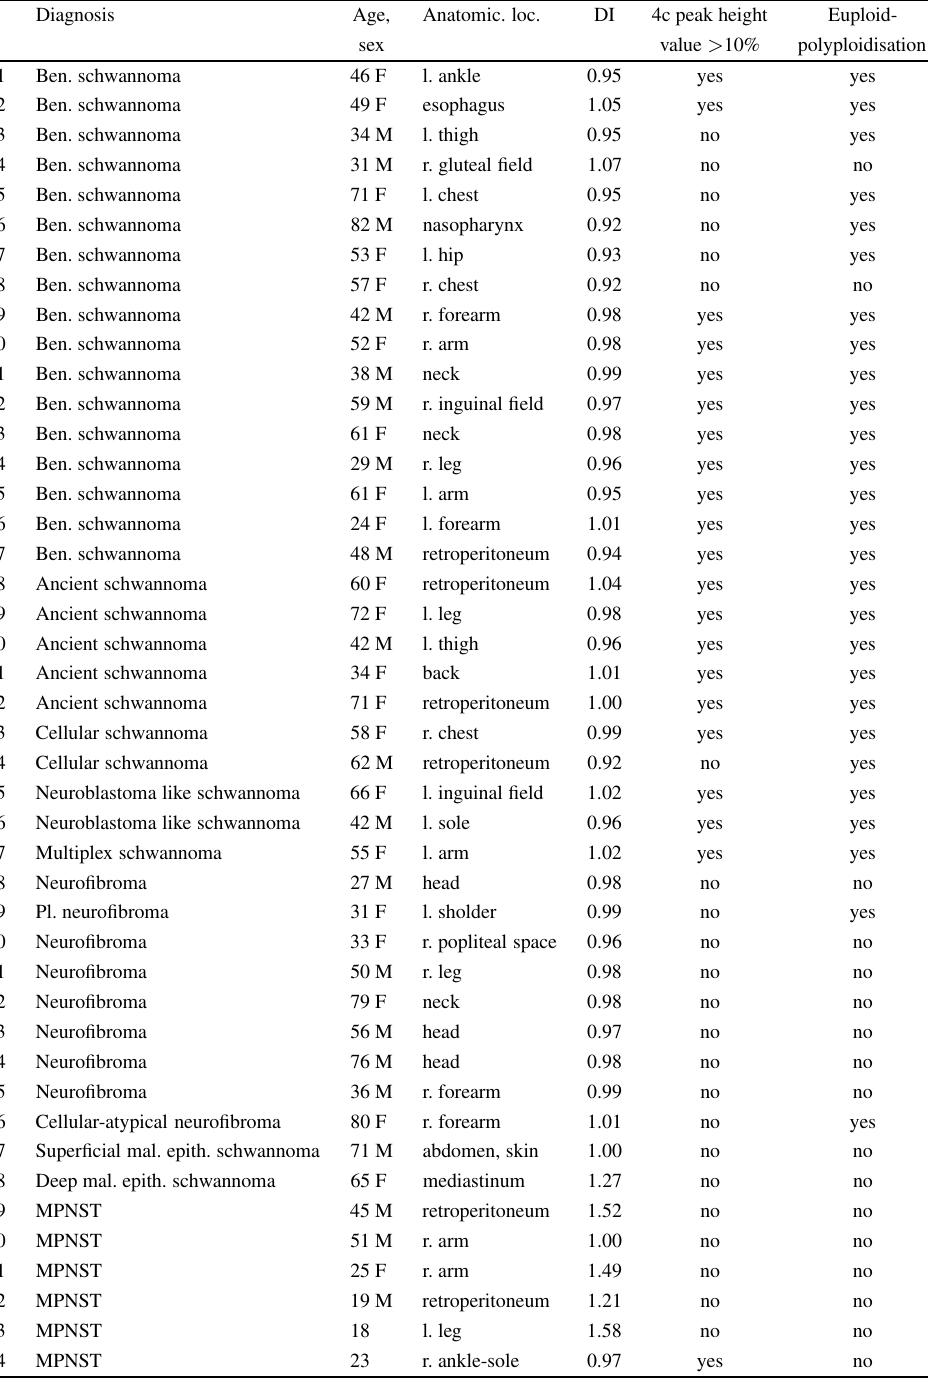
Clinical data and DNA ploidy pattern of 44 peripheral nerve sheath tumors Diagnosis Age, Anatomic. loc.